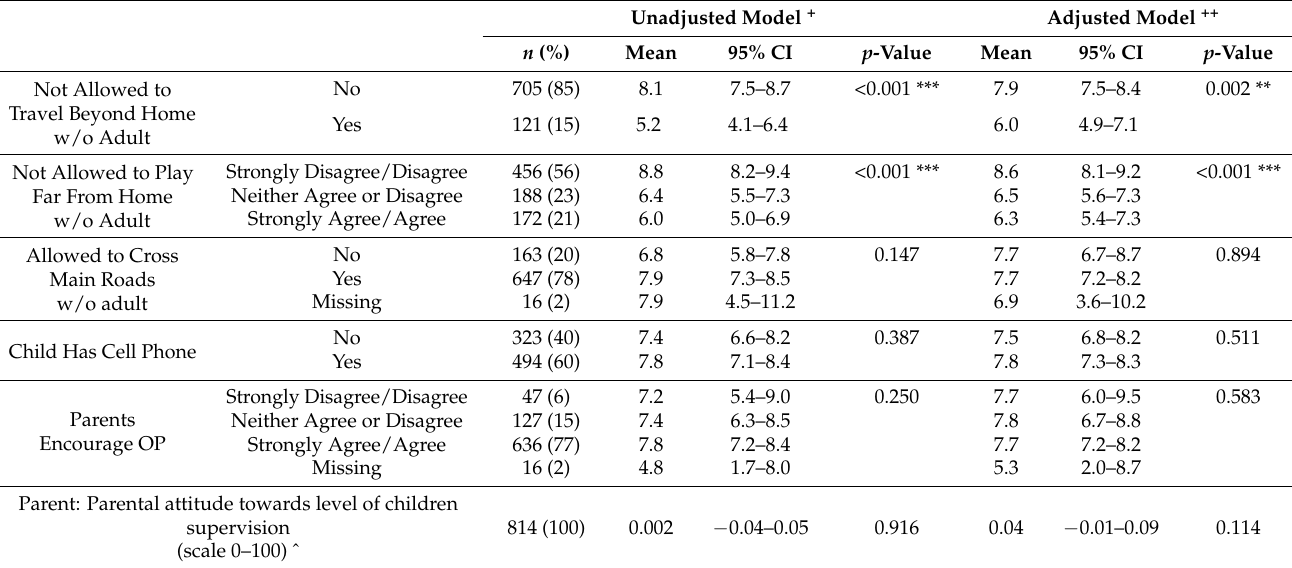
Table 5. Children’s License for Community Activity and Mobility: Descriptives and Model 3 Results. Adjusted model controls for demographic variables in Model 1 (Table 3) 1